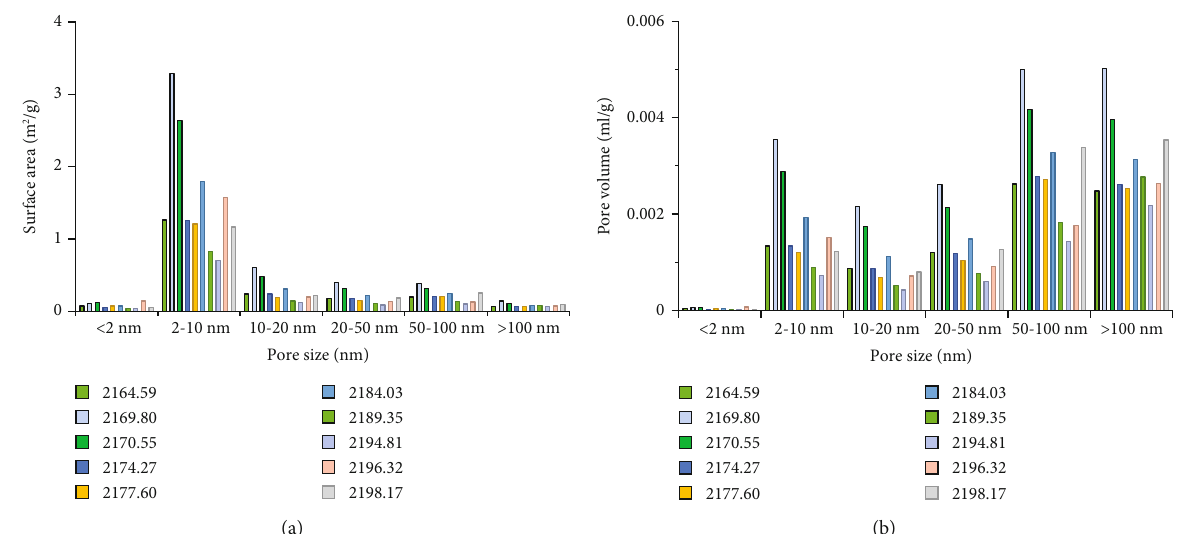
Figure 9: (a) Cumulative pore volume and (b) pore surface area of di ff erent pore diameter ranges for limestone samples with di ff erent